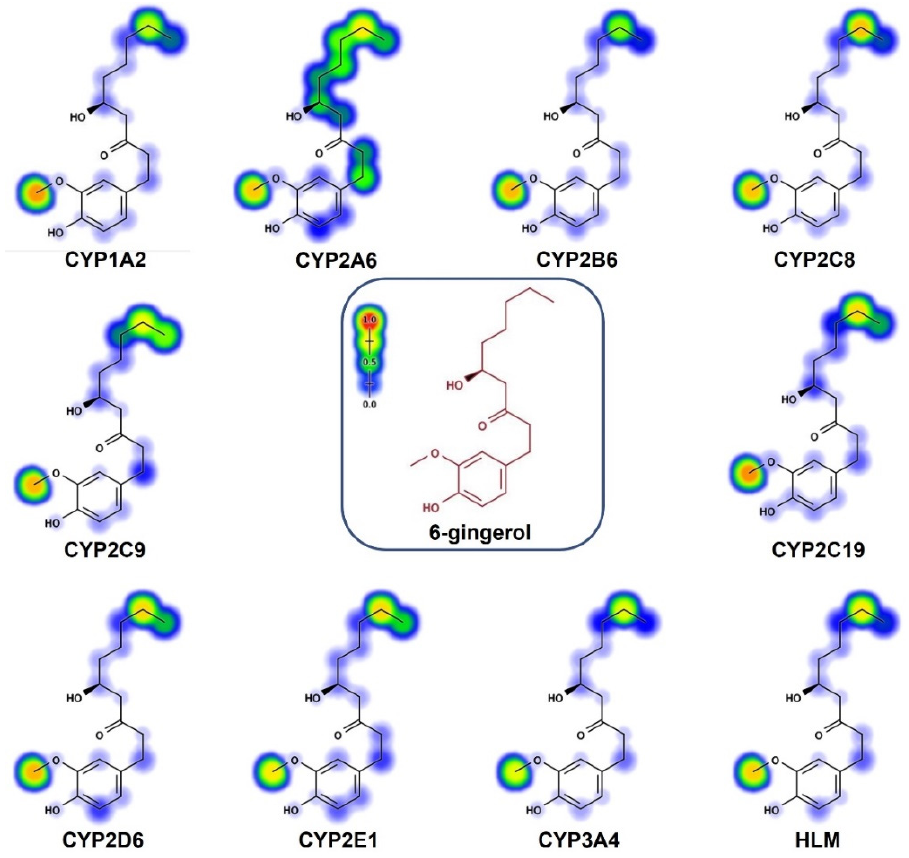
Figure 6. In silico evaluation of the metabolism of 6-gingerol. Metabolic sites (SOM) of 6-gingerol mediated by CYP450 isoenzymes (CYP1A2, CYP2A6, CYP2B6, CYP2C8, CYP2C9, CYP2C19, CYP2D6, CYP2E1, CYP3A4, and HLM).